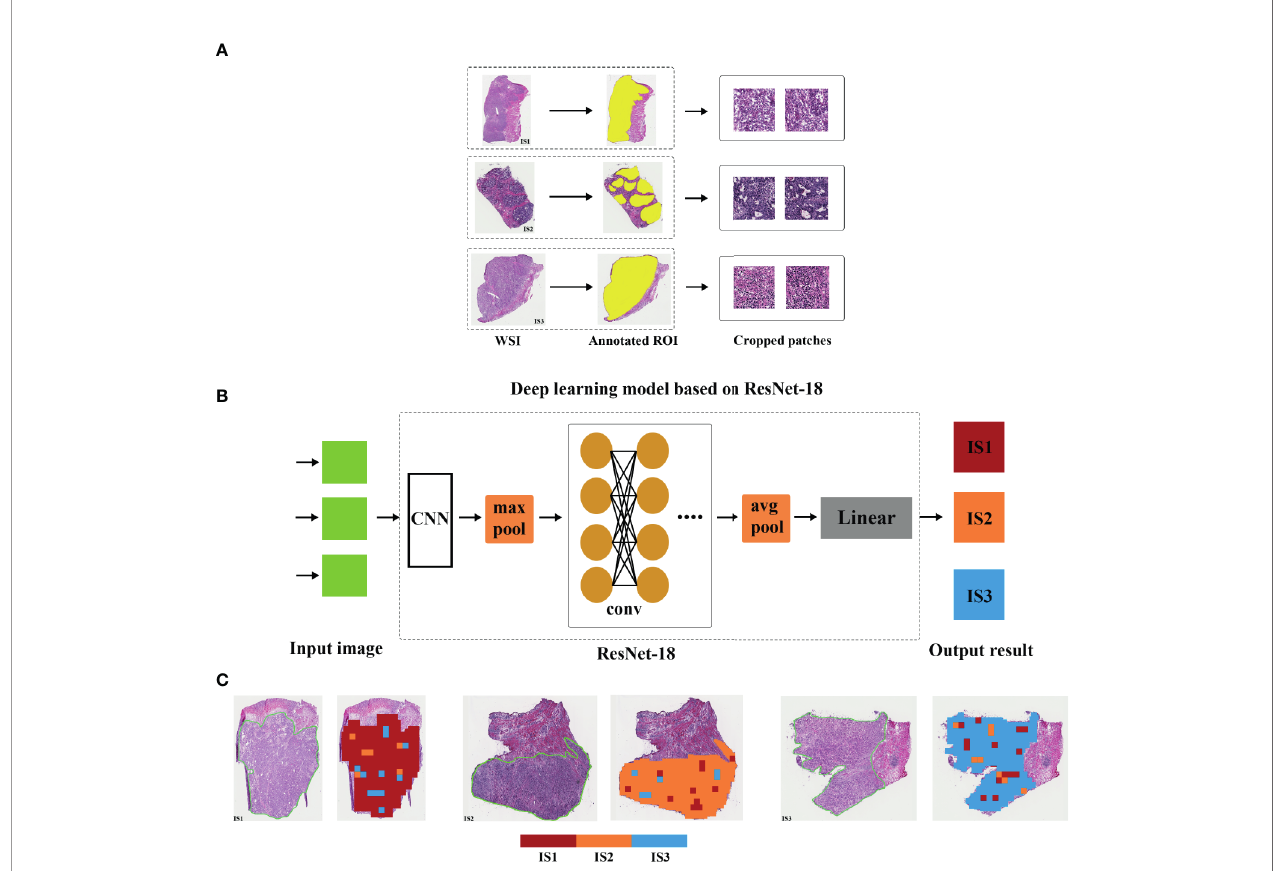
FIGURE 6 | Overview of the deep learning model. The whole slide image (WSI) of each patient was obtained and annotated with regions of carcinoma (ROI) (A) . Then, tumor of ROI was segmented into patches, and the immune subtypes likelihood of each patch was predicted by deep learning model based on ResNet-18 (B) . Finally, multiple patch-level IS likelihoods were integrated into a WSI-level IS prediction (C)